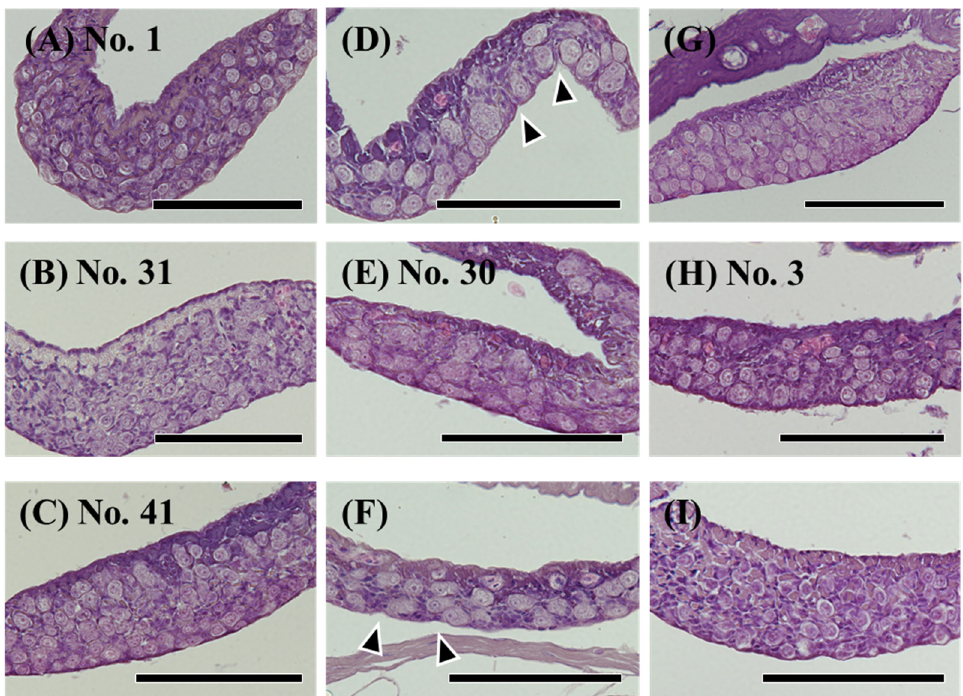
Figure 3. Hematoxylin-eosin (HE) staining of undifferentiated gonads in the wild Japanese eel Anguilla japonica . ( A – C ) Gonads of testis-like structures. ( D – F ) Gonads of ovary-like structures. ( G – I ) Undifferentiated gonads. Total lengths are ( A ) 250, ( B ) 305, ( C ) 313, ( D ) 281, ( E ) 299, ( F ) 310, ( G ) 251, ( H ) 257, ( I ) 318 mm. Arrowheads, notches in the epithelium of the ovary. Individual numbers (Nos.) correspond to those in Table 5 and Figures 10 and 11. Scale bar, 100 µm.